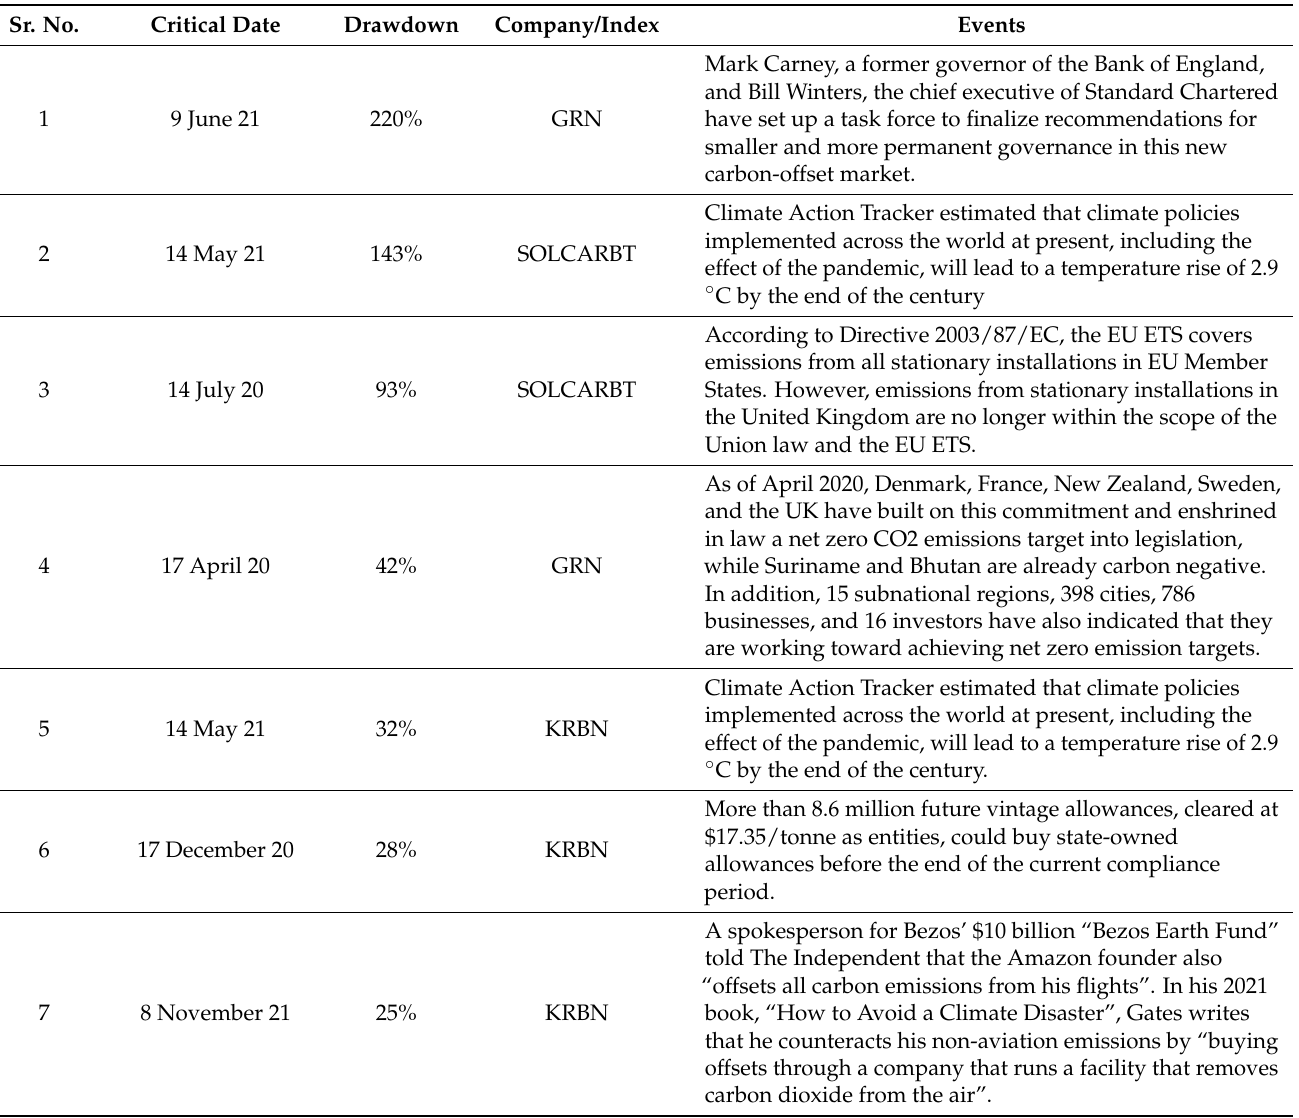
Table 3. Event linking with extremely large LPPL Drawdowns ( > 25% )